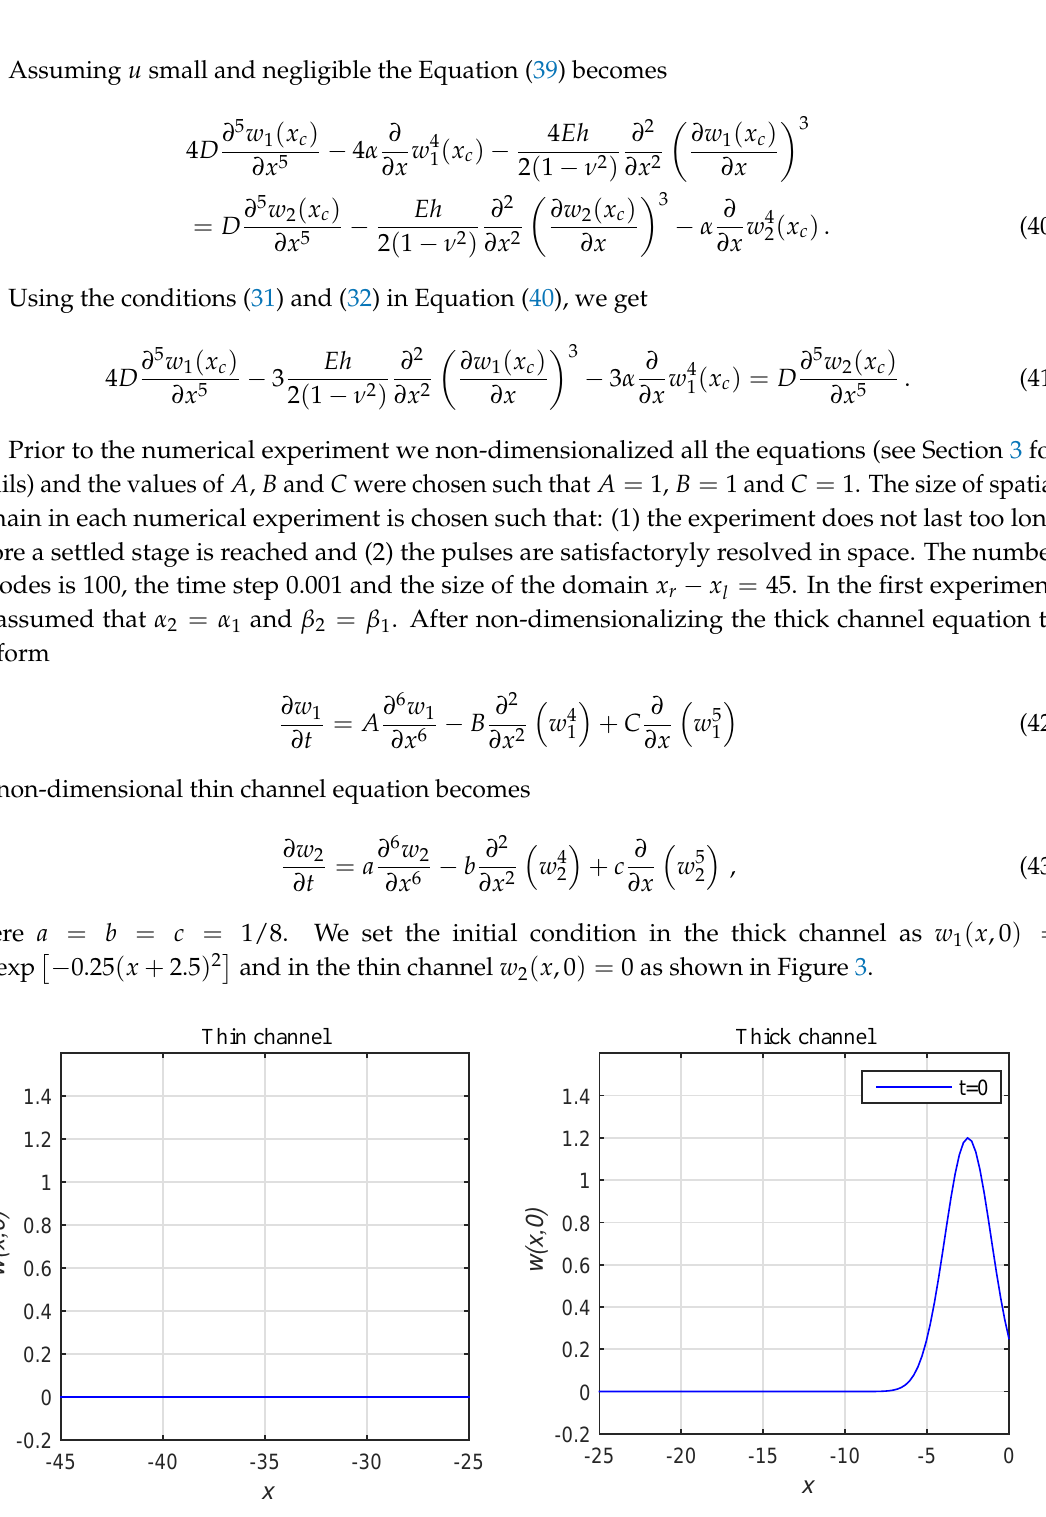
Figure 3. The initial condition initiating the pulse in the thick